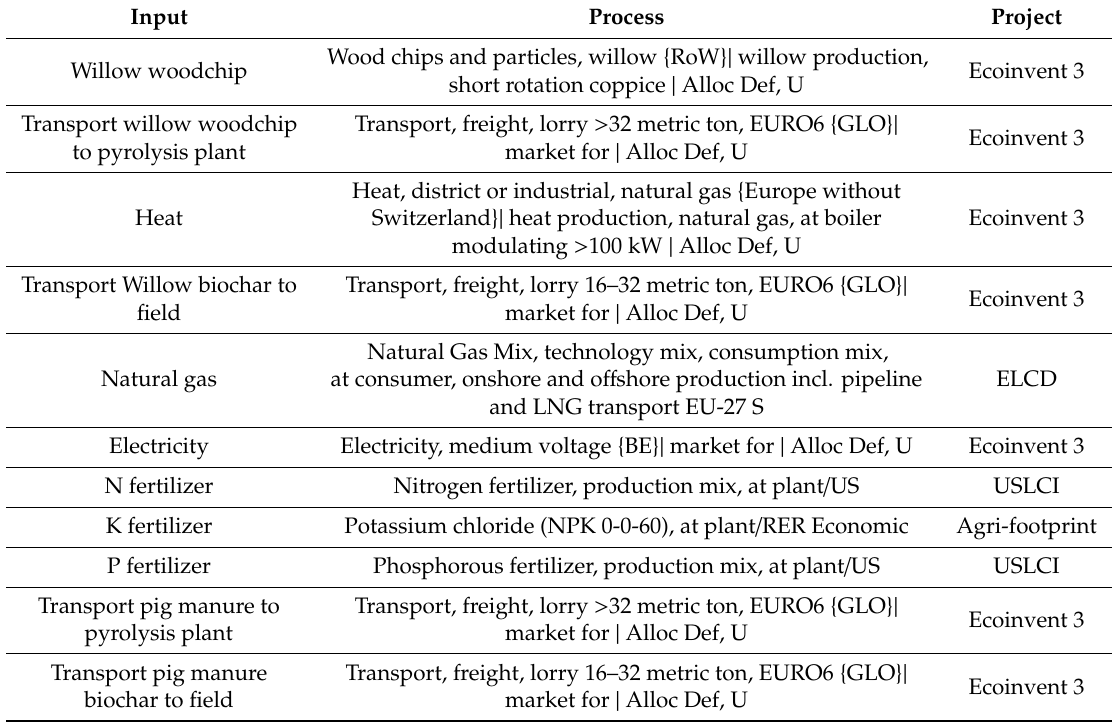
Table A1. List of the processes extracted from SimaPro in this study.